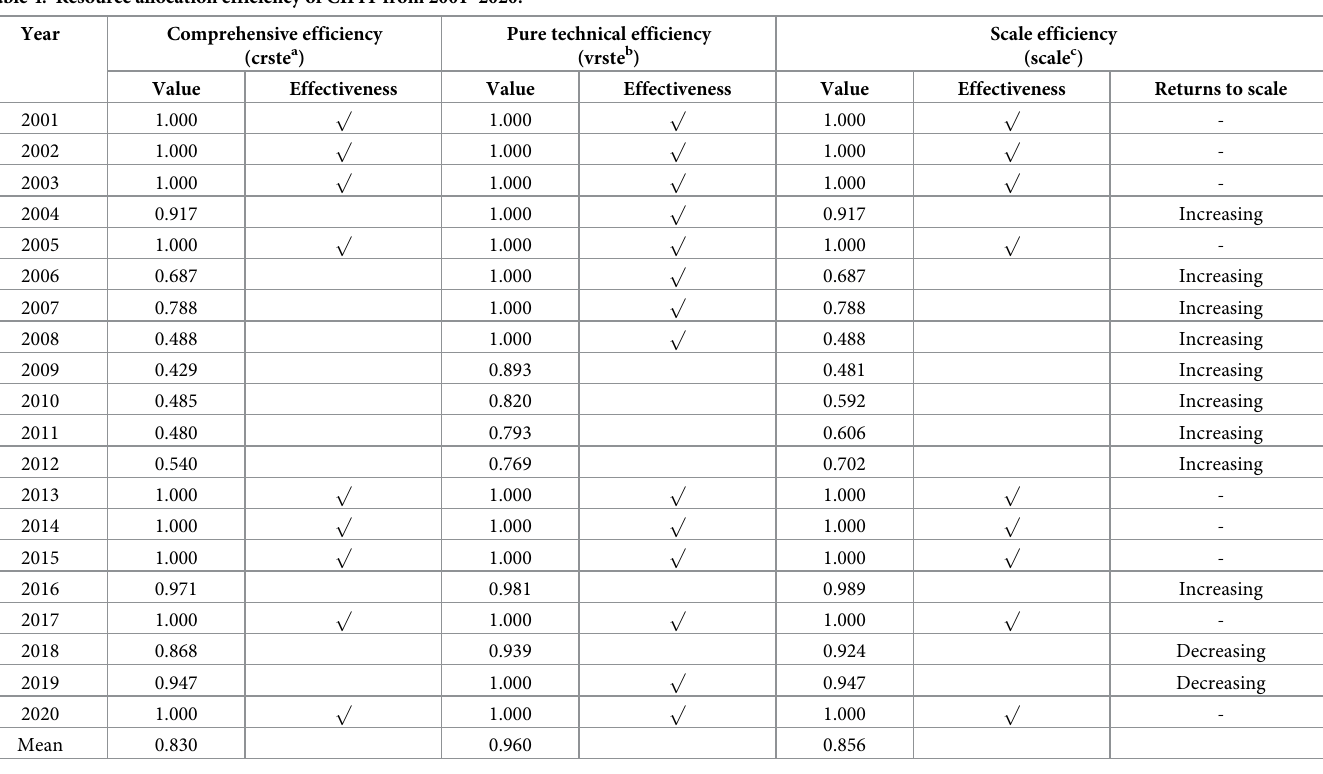
Table 4. Resource allocation efficiency of CIFIT from